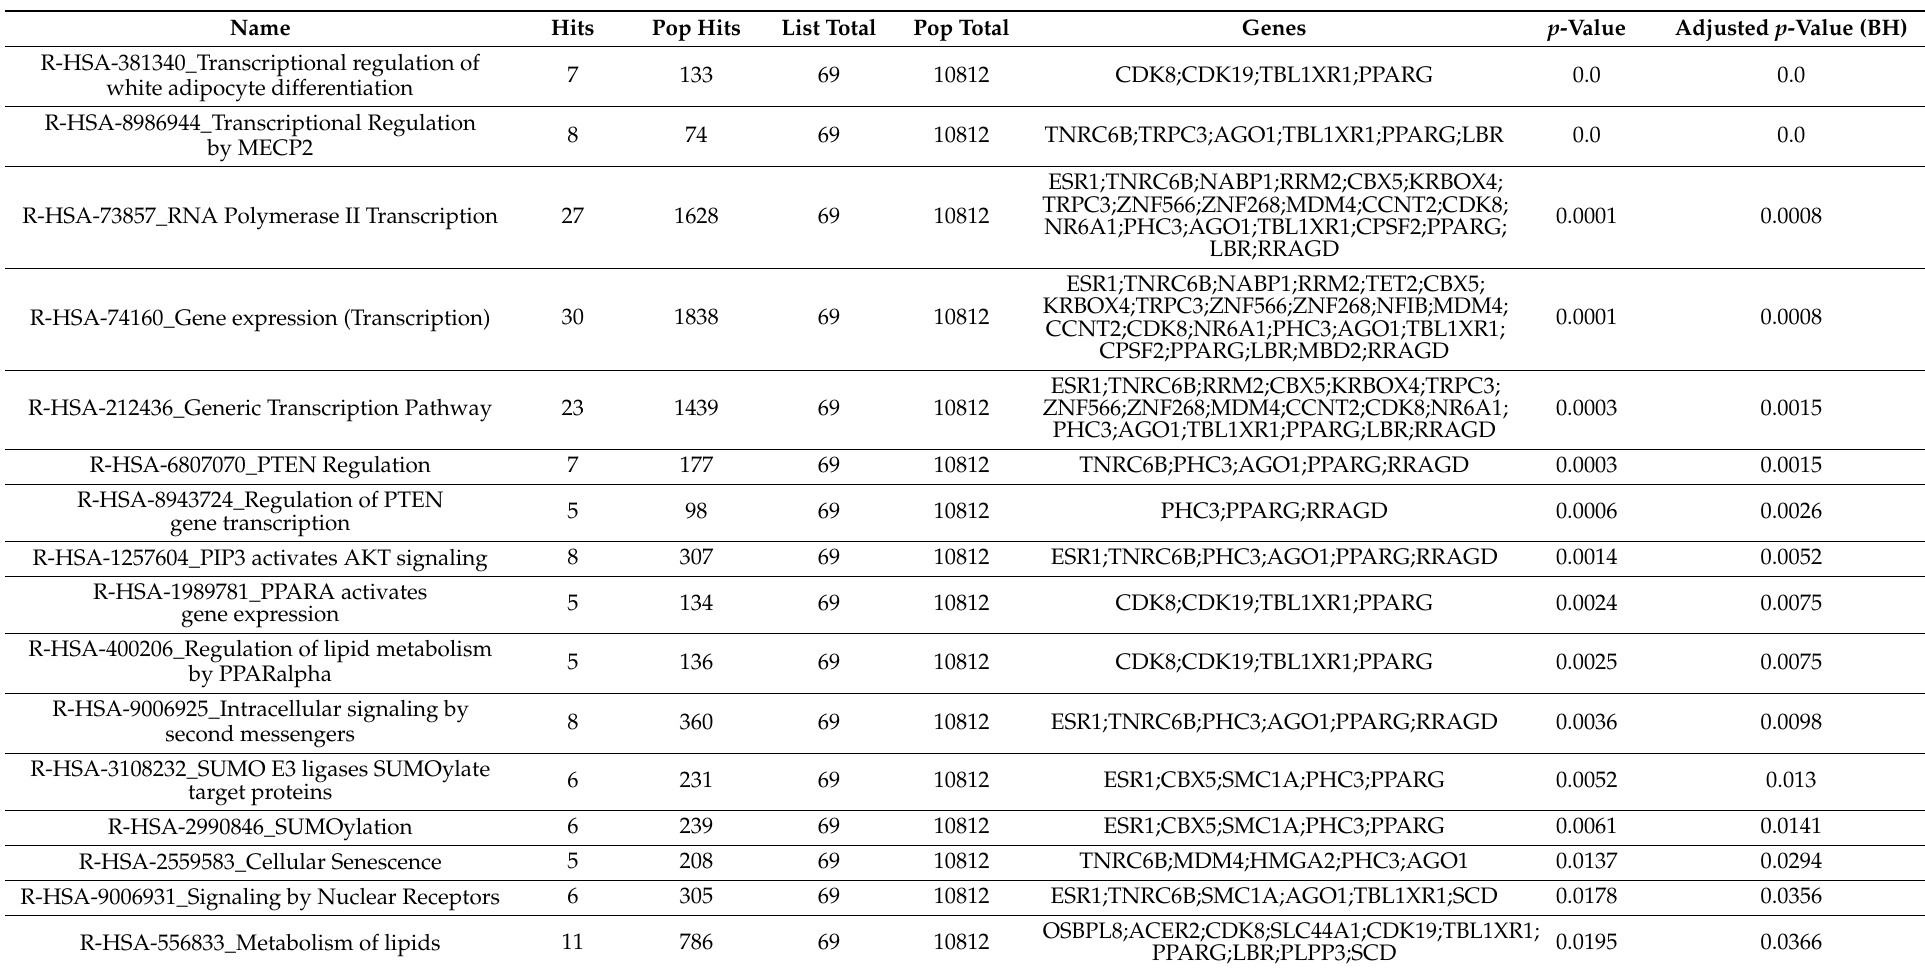
Table 1. Reactome pathways with adjusted p value ≤